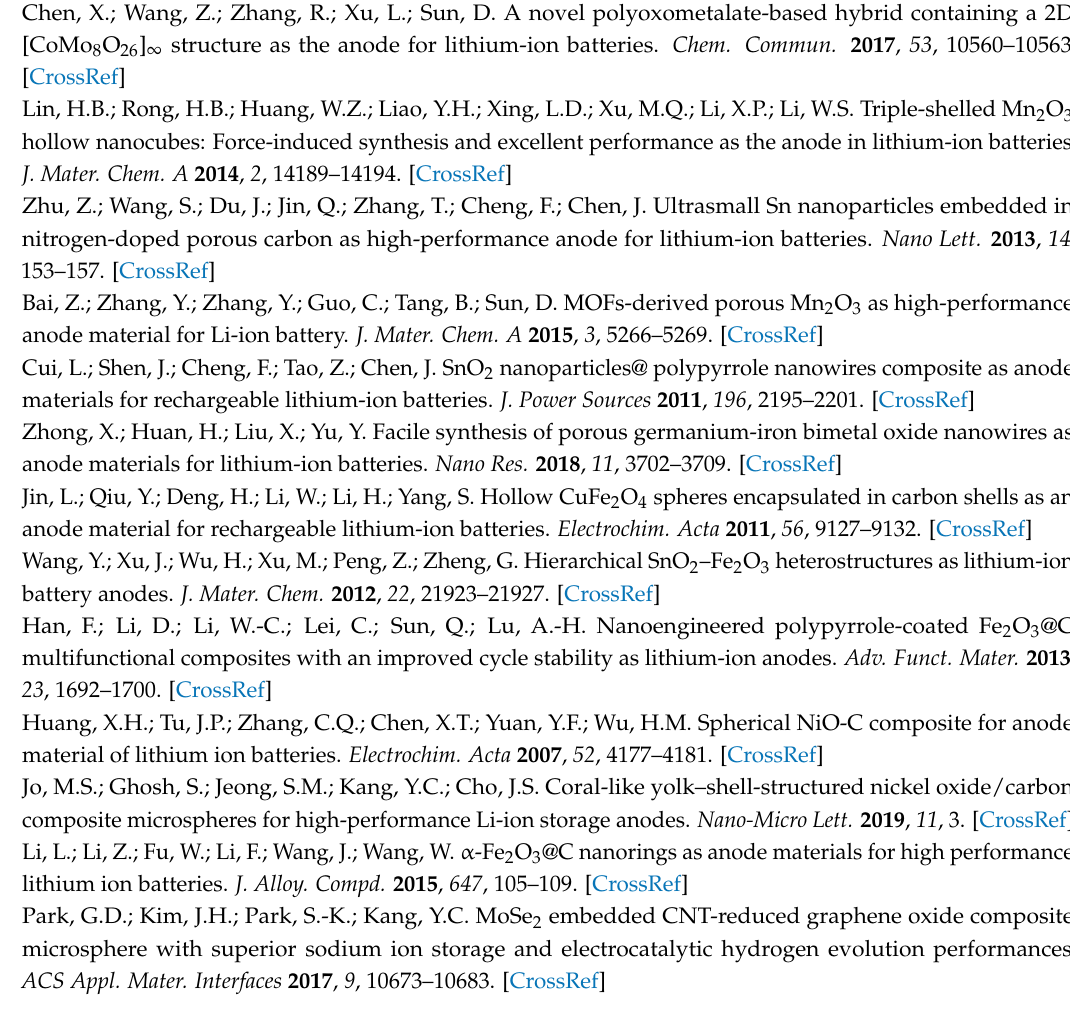
Figure S1: Schematic diagram of spray pyrolysis system applied in the preparation of MoO 3 /C composite microspheres, Figure S2: N 2 adsorption-desorption isotherms measured at 77 K for the MoO 3 /C composite microspheres and bare MoO 3 powders, Figure S3: Cycle properties of the MoO 3 /C composite microspheres and the bare MoO 3 powders, Figure S4: TGA curve of the bare MoO 3 powders, Table S1: Fitted data obtained from the equivalent circuit for Nyquist plots.